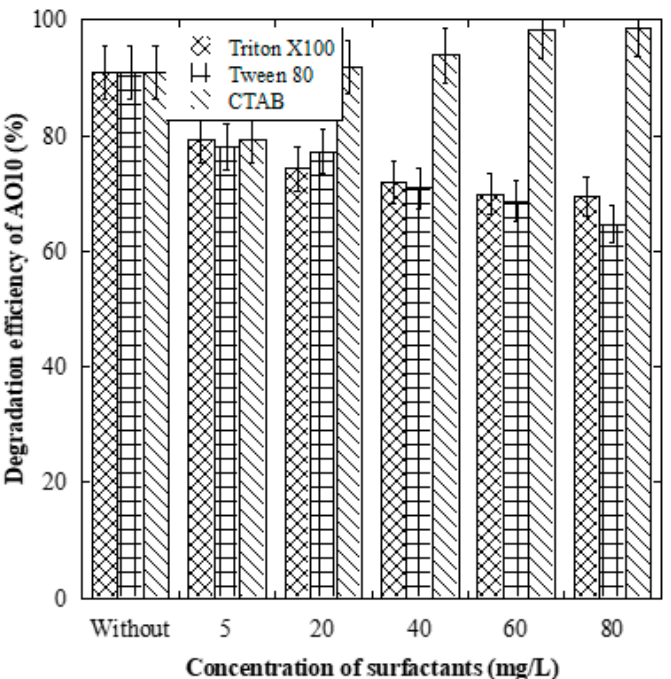
Figure 11. Effect of surfactants on the AO10 degradation ([AO10] 0 = 50 mg/L, 20 ± 1 °C, [IO 4 − ] = 3 mM, irradiation intensity: 15 mW/cm²).